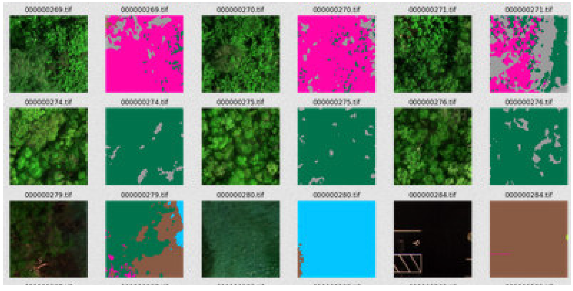
Figure 8: JILONA North training data